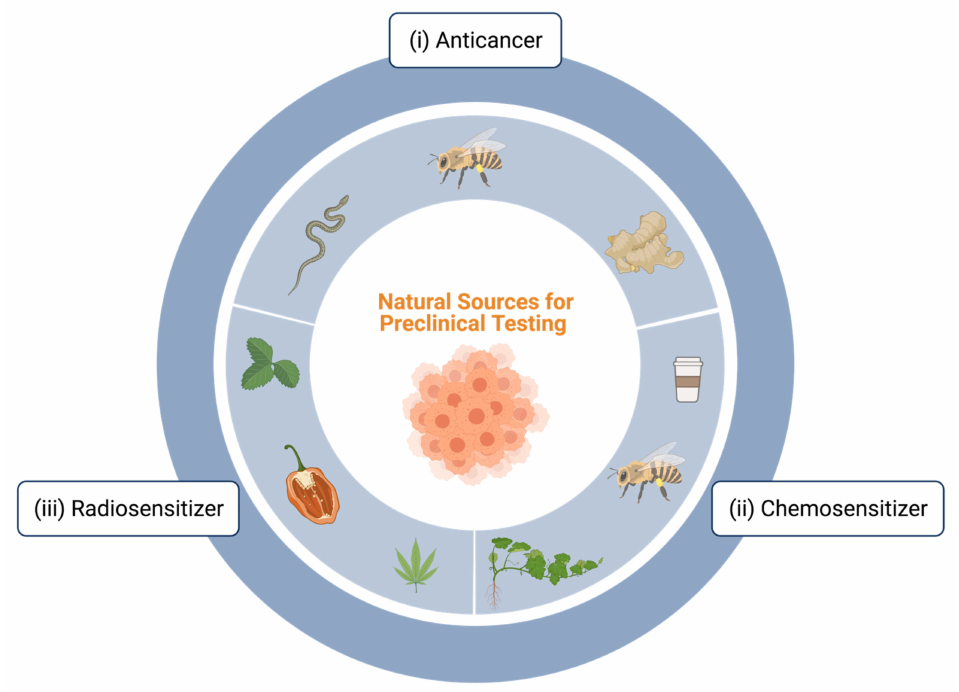
Figure 2. Emerging anticancer and treatment sensitizing compounds from natural sources against pancreatic cancer. Various natural sources have emerged demonstrating (i) anticancer potential in preclinical testing against PDAC cells including, mohave rattlesnake ( Crotalus scutulastus ), prairie rattlesnake ( Crotalus viridis ) and honeybee ( Apes mellifera ) venom, extracts from date palm fruit ( Phoenix dactylifera ), ginger root ( Zingiber officinale ), and cold atmospheric plasma (CAP), (ii) chemosensitizing potential in preclinical testing against PDAC cells including, oridonin isolated from a traditional Chinese medical herb (Rabdosia rubescens), trigonelline, a natural constituent of coffee, melittin isolated from honeybee ( Apes mellifera ) venom, curcurbitacin D, a compound isolated from members of the pumpkin and gourd family (Cucurbitaceae), curcumin ( Curcuma longa ) isolated from members of the turmeric and ginger family (Zingiberaceae), and (iii) radiosensitizing potential in preclinical testing against PDAC cells including, curcumin ( Curcuma longa ), neem ( Azadirachta indica ), and raspberry ( Rubus idaeus ) leaf extract, capsaicin, a vanilloid compound, (an active ingredient in hot peppers), and resveratrol, a member of the stilbene family, ascrobate (P-AscH − , vitamin C), cannflavin B, a non-cannabinoid, non-psychoactive derivative